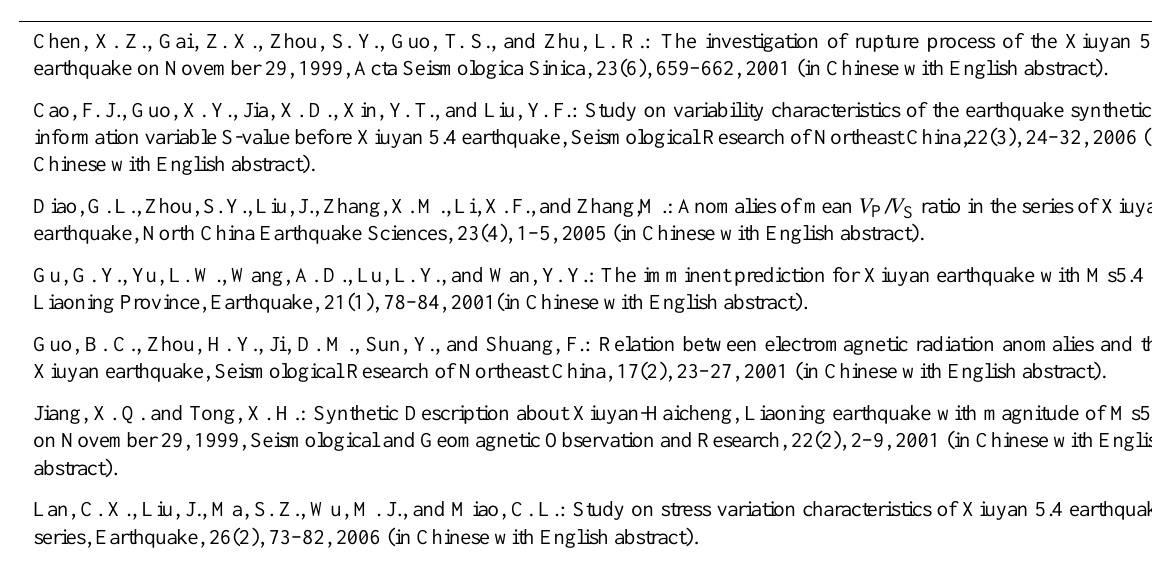
Table A3. References related to the prediction of the 1999 Xiuyan